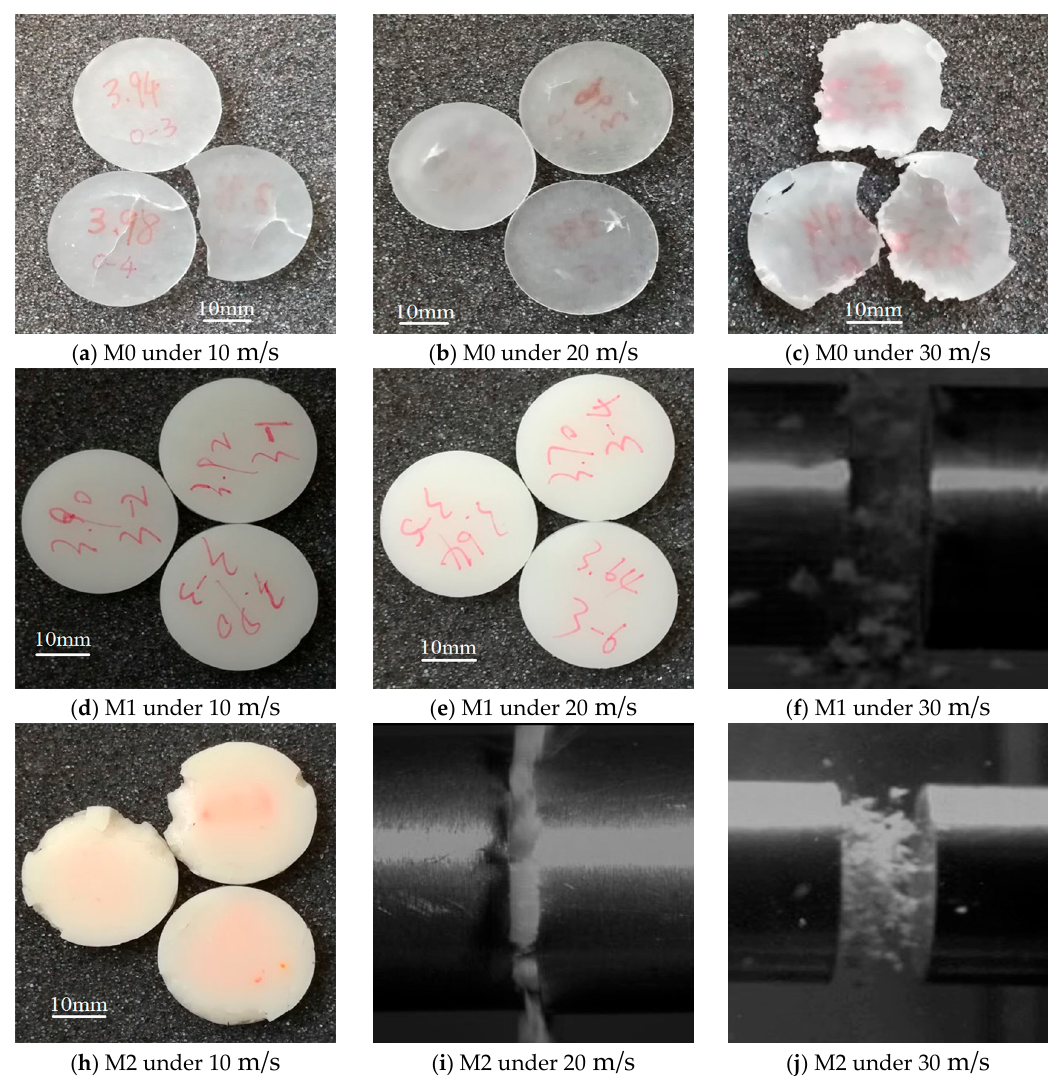
Figure 8. Final shape of specimens with different LNBR content at different impact loading: ( a – e , g ) show the recovered samples with high integrity; ( f – i ) show the moment when the specimens crushed into powder.